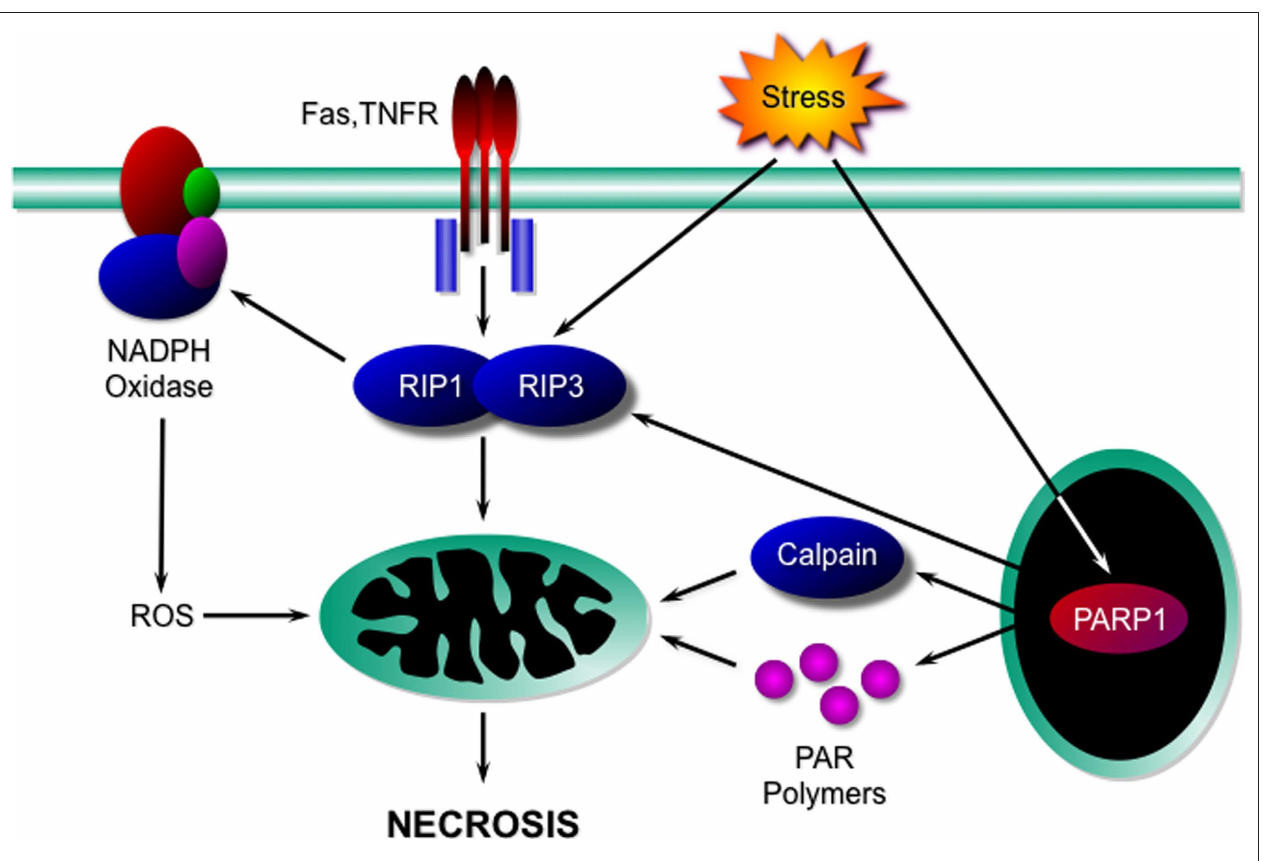
which can potentially induce necrosis either through activation of the RIP kinases, activation of calpains, or through the production of PAR polymers. TNFR, TNF α receptor; RIP, receptor interacting protein; ROS, reactive oxygen species; PAR, poly(ADP-ribose); PARP1, poly(ADP-ribose)